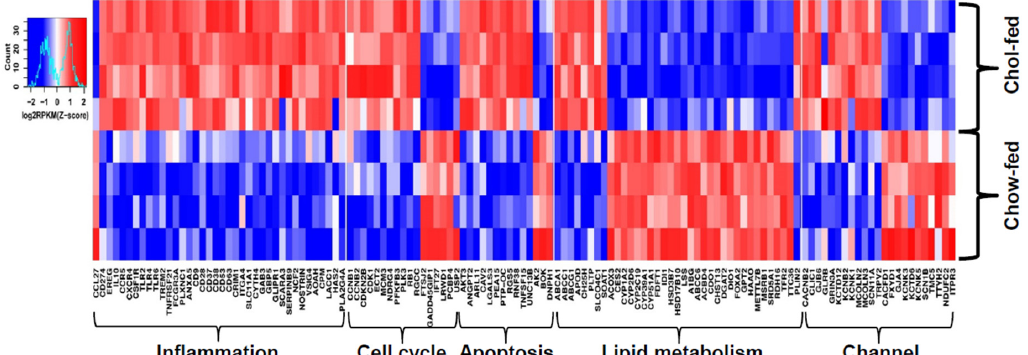
Figure 4. Heatmap of DEGs in the livers of chow-fed and cholesterol-fed rabbits. Four male rabbits from each group were analyzed and individual data were shown. These DEGS were classified into four groups: 39 DEGs are related with Inflammation including receptors, ligands, membrane proteins, cytoplasm proteins and enzymes; 33 DEGs related with cell growth and apoptosis, 36 DEGs related with lipid metabolism; 24 DEGs related with cell membrane channels. The color brightness in heatmap indicate the normalized z-scores of log2-transformed gene expression values. Red color represents for a relatively high expression value whereas blue color for low expression value. n = 4 for each group. EREG; epiregulin, NOSTRIN; nitric oxide synthase trafficking, AOAH; acyloxyacyl hydrolase, CPM; carboxypeptidase M, RGCC; regulator of cell cycle, PTP-OC; protein tyrosine phosphatase, receptor type O, BOK; bcl-2 related ovarian killer, APOD; apolipoprotein D, PLTP; phospholipid transfer protein, LSS; lanosterol synthase, HAAO; 3-hydroxyanthranilate 3,4- dioxygenase, GLRB; glycine receptor beta.